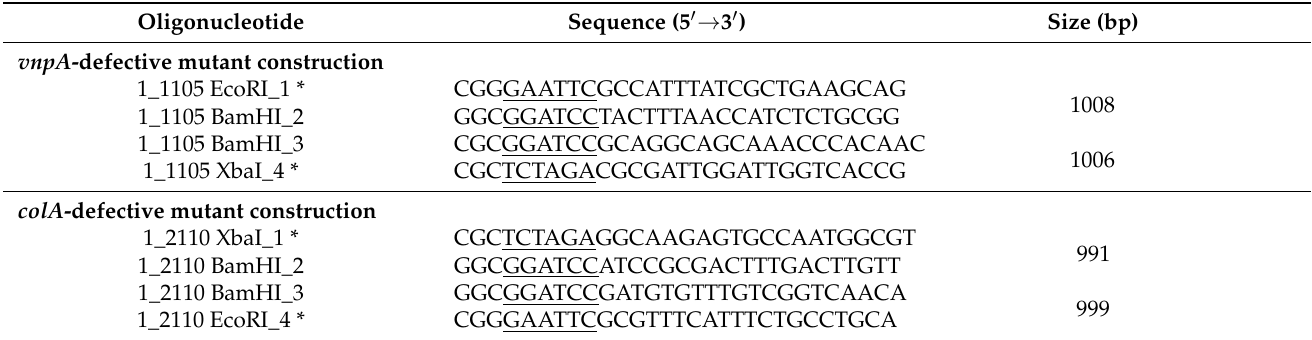
Table 2. Oligonucleotides used for the construction of mutants. Recognition sequences for restriction enzymes are underlined.